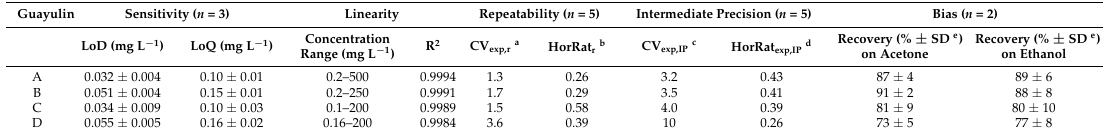
Table 3. Validation data.